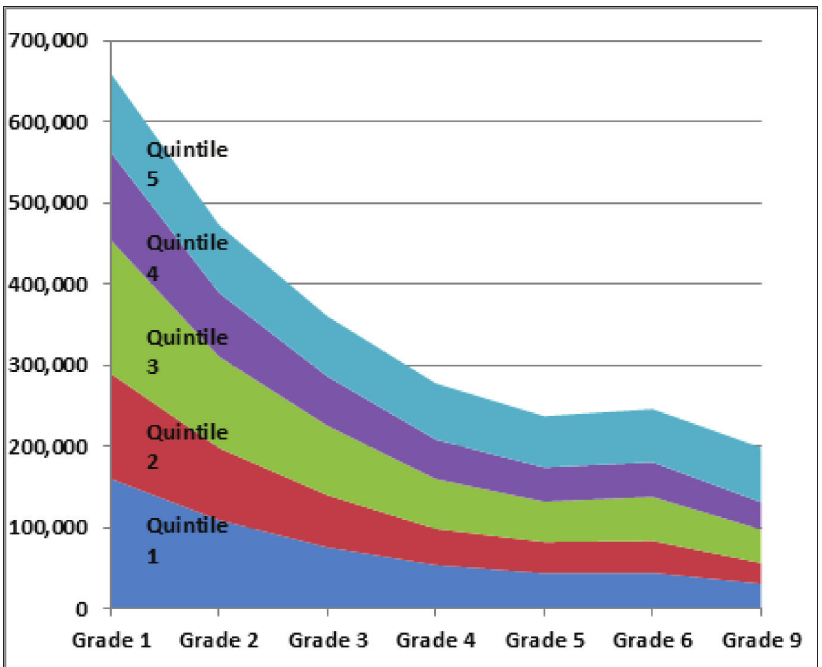
Figure 2: Number of students on track in ANA 2012 by school quintile (Source: Own calculations from ANA